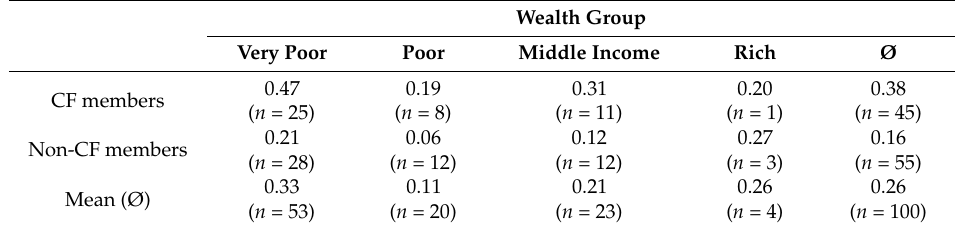
Table 3. Contribution of CF to total household income for different community